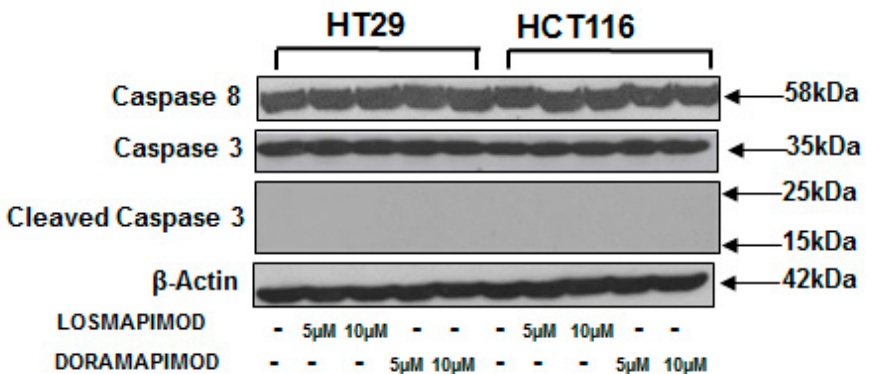
Figure 6. Inhibition of p38 MAPKs did not alter the caspase 8 or caspase 3 activity in CRC cells. HCT-116 and HT-29 CRC cell lines were treated with di ff erent doses of losmapimod or doramapimod or DMSO (control) for 48 h. Whole cell extracts were prepared and subjected to SDS-PAGE. Western blotting was performed using specific antibodies to caspase 8 and caspase 3. Equal loading was confirmed with β -actin. As shown above, neither caspase 3 or caspase 8 levels were altered by losmapimod or doramapimod.